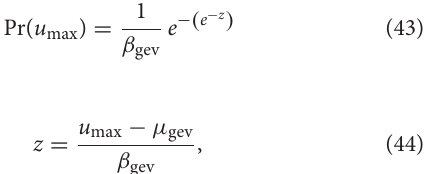
FIGURE 3 | Distribution of maximum displacements for different system sizes as obtained from GFMD (closed symbols). Considered system sizes are N 128 128 (diamonds), 512 512 (squares), 2048 2048 (circles). = × × × Comparison is made to the distribution of the maximum of N ′ 0.92 N = independent random numbers of mean zero and variance 1 u (open symbols) as well as to the corresponding Gumbel